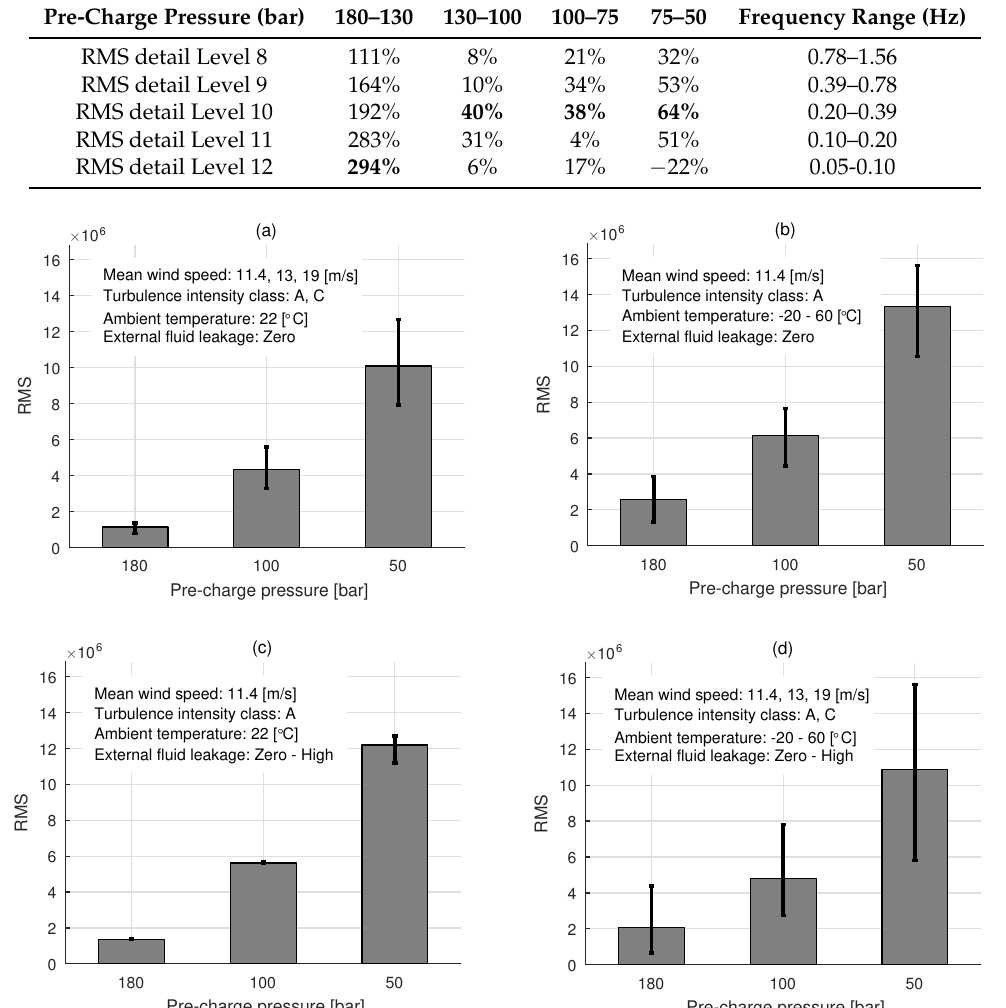
Figure 9. Mean value of the detail coefficient RMS decomposition Level 10 for: ( a ) different mean wind speeds and turbulence intensity classes; ( b ) different ambient temperatures; ( c ) different external fluid leakage levels; ( d ) all combinations of operating conditions and faults. The error bars indicate the full range of RMS